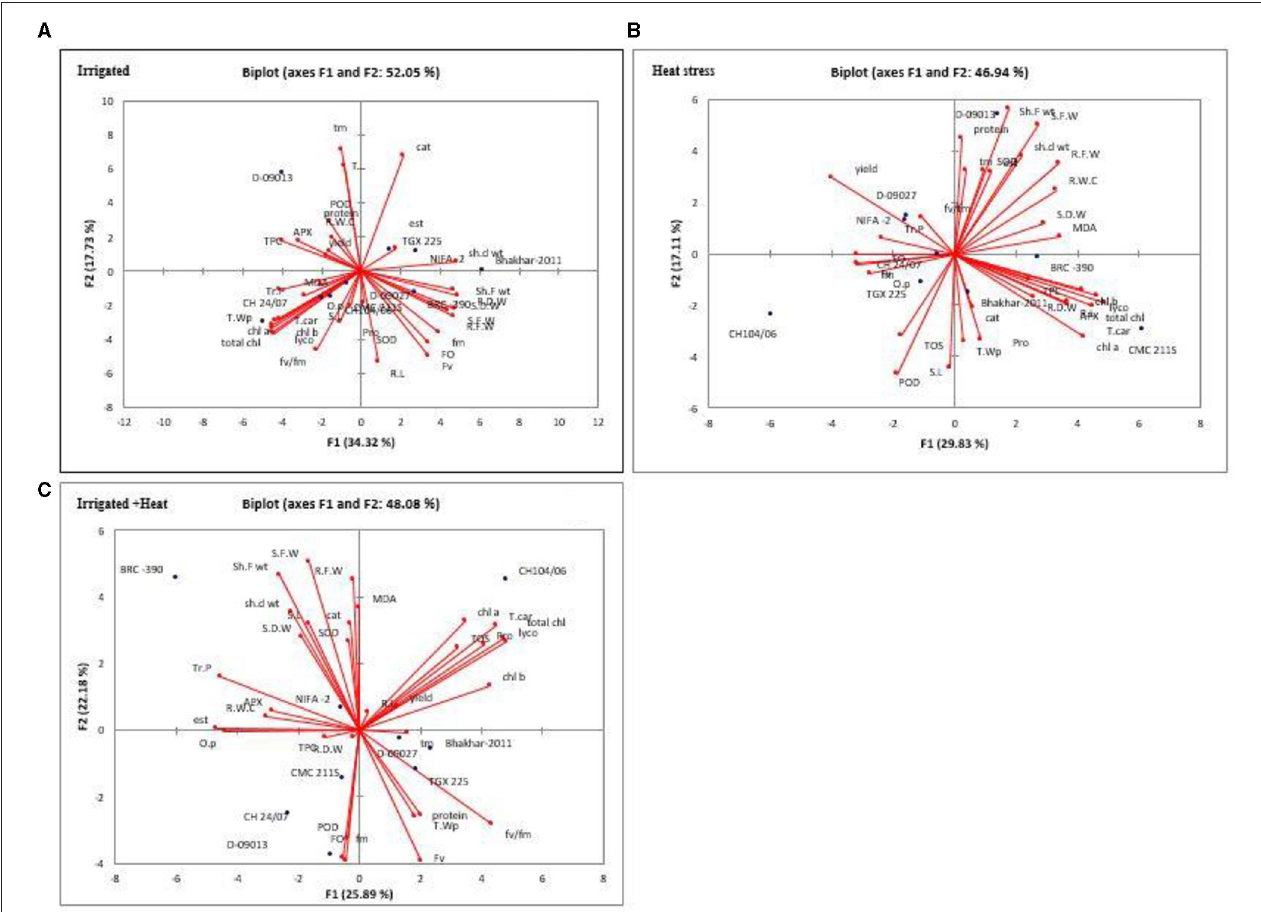
FIGURE 5 | Biplots of first two principal components (PC-I and PC-II) for irrigated (A) , heat (B) , and combined (H + I) effect (C) . S.L, Shoot Length; R.L, Root Length; S.F.W, Seedling Fresh Weight; Sh. F Wt, Shoot Fresh Weight; Sh.D Wt, Shoot Dry Weight; R.F.W, Root Fresh Weight; R.D.W, Root Dry Weight; T. W P, Total Water Potential; O.P, Osmotic Potential; Tr.P, Turgor Potential; R.W.C, Relative Water Content; Fo, Minimal Fluorescence; Fm, Maximal Fluorescence; Fv, Variable Fluorescence; Fv/Fm, ratio of variable chlorophyll fluorescence and minimal chlorophyll fluorescence; Lyco, Lycopene; Chla, Chlorophyll A; Chlb, Chlorophyll B; Total Chl, Total Chlorophyll; T.Car, Total Carotenoids; TOS, Total Oxidant Status; SOD, Superoxide Dismutase; CAT, Catalase; TSP, Total Soluble Protein; MDA, Malondialdehyde; TPC, Total Phenolic Contents; POD, Peroxidase; APX, Ascorbate peroxidase; Tm, time of achieving maximum fluorescence yield.